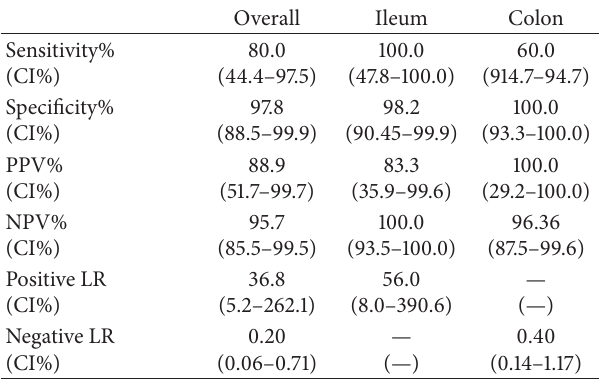
Table 4: Sensitivity, specificity, PPV, and NPV of POCUS relative